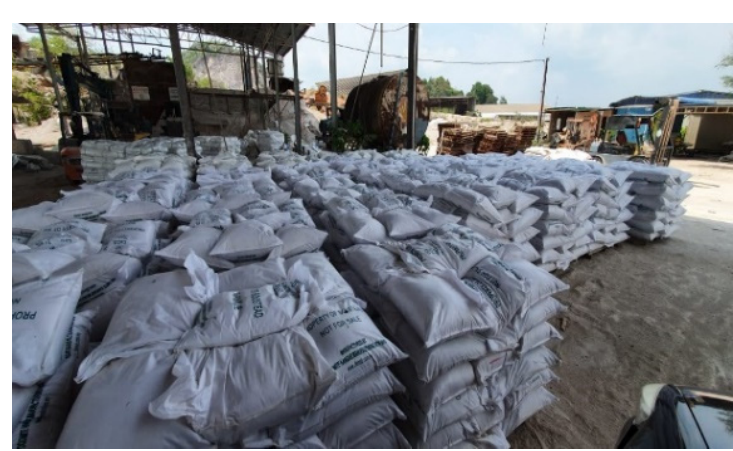
Figure 8. Packed dolomite for use as fertilizer (own photograph). Table 2. Summary of dolomite